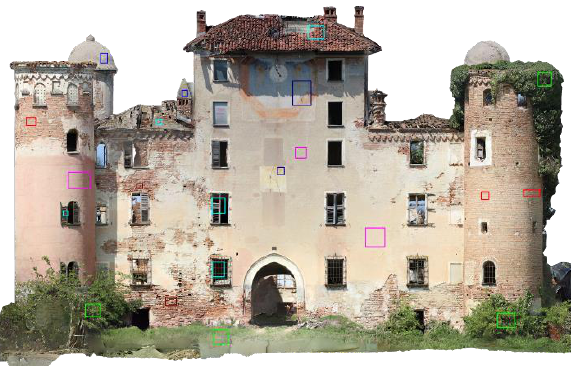
Figure 8. Original orthophoto of the Castle of Bonavalle.